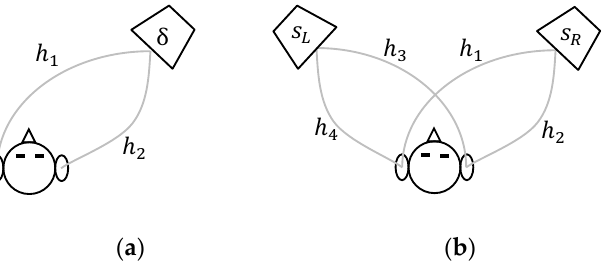
Figure 8. Using head-related impulse responses (HRIRs) to render ( a ) a monophonic system and ( b ) a stereophonic system.